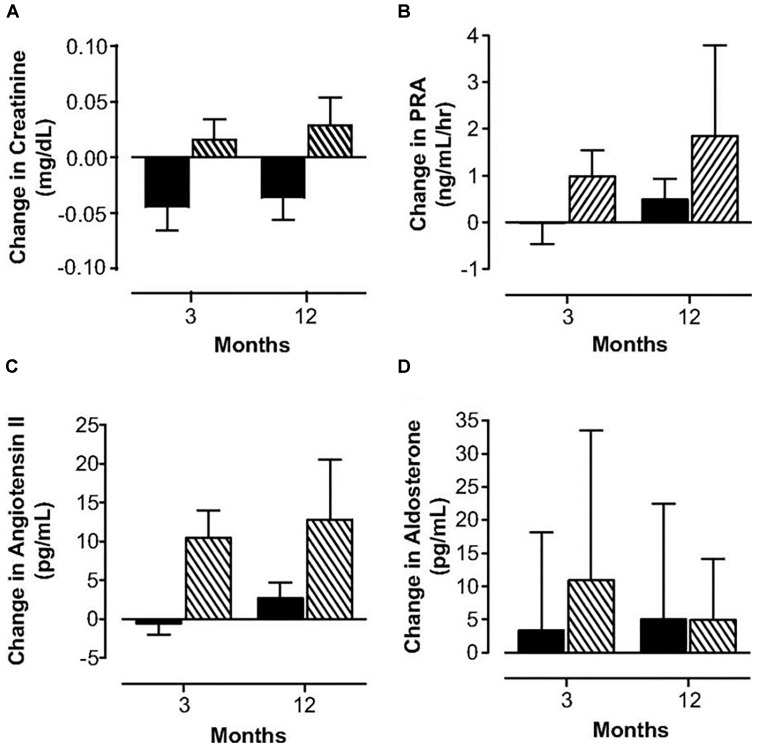
Changes in serum creatinine (A), plasma renin activity (B), angiotensin II (C) and aldosterone (D) concentrations in women with POI treated with physiologic HRT () or standard OCPs (). Langrish et al. (2009).